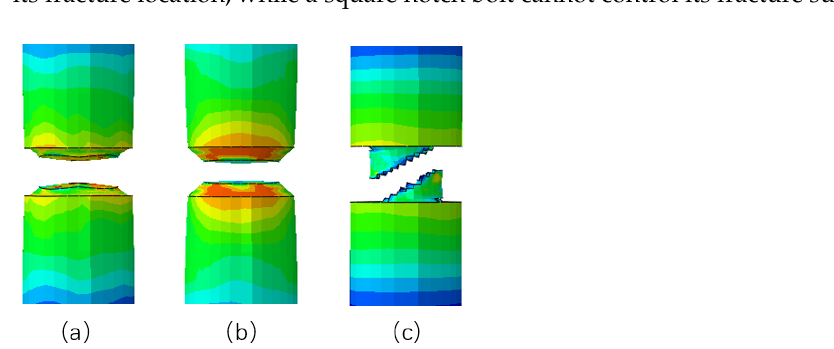
Figure 8. Simulated fracture appearances. ( a ) arc-shaped; ( b ) V-shaped; ( c ) square notch.